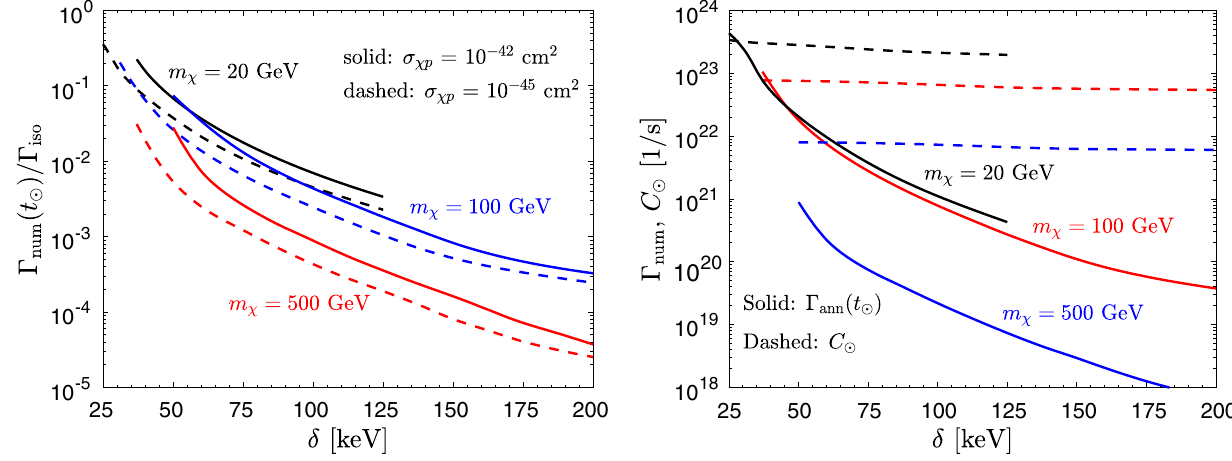
Fig. 9 Left panel Ratio of the annihilation rates calculated with the numerically obtained distribution and with the isothermal distribu- tion using σ χ p = 10 − 42 cm 2 (solid lines) and σ χ p = 10 − 45 cm 2 (dashed lines). Right panel: Annihilation rates (solid lines) and capture